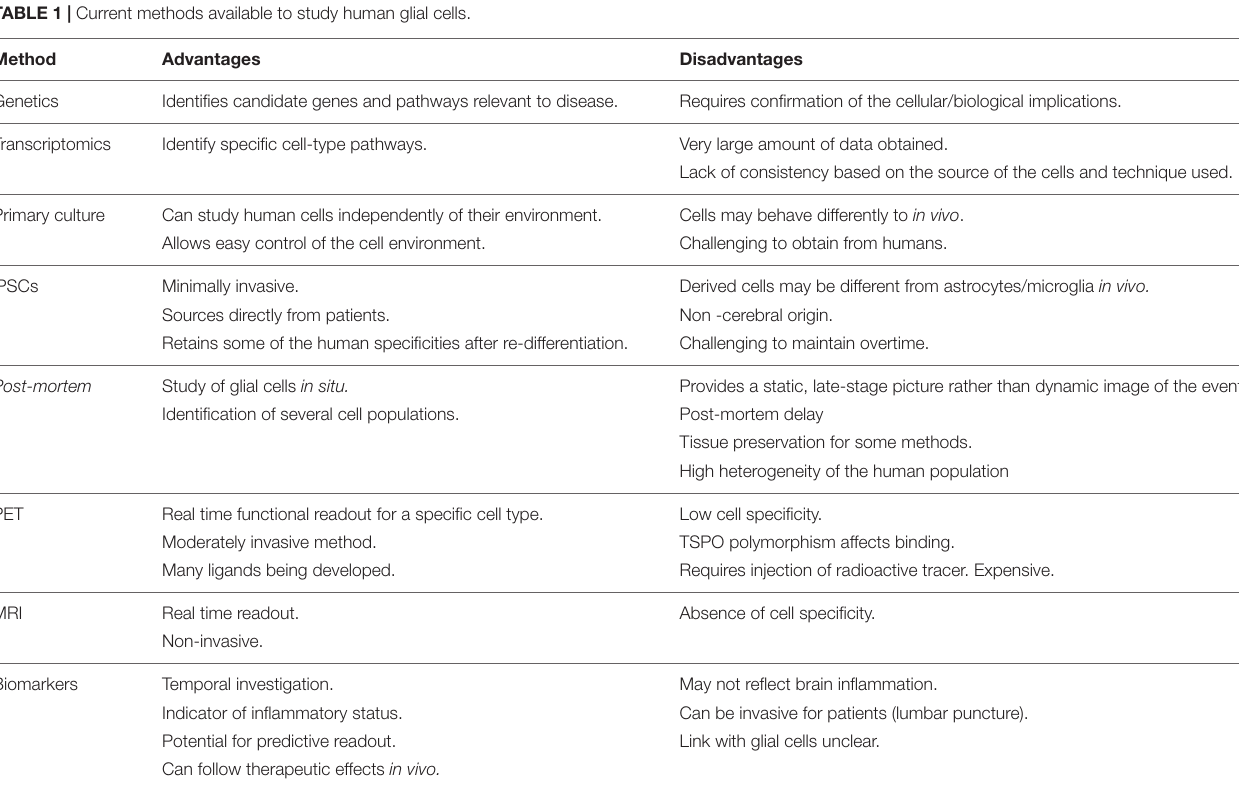
TABLE 1 | Current methods available to study human glial